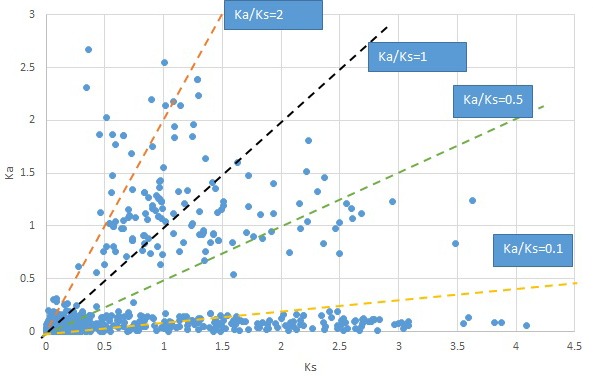
Plot of Ka and Ks values for each POG in 20 taxon pairs, in alphabetical order of genus names.Sassafras.